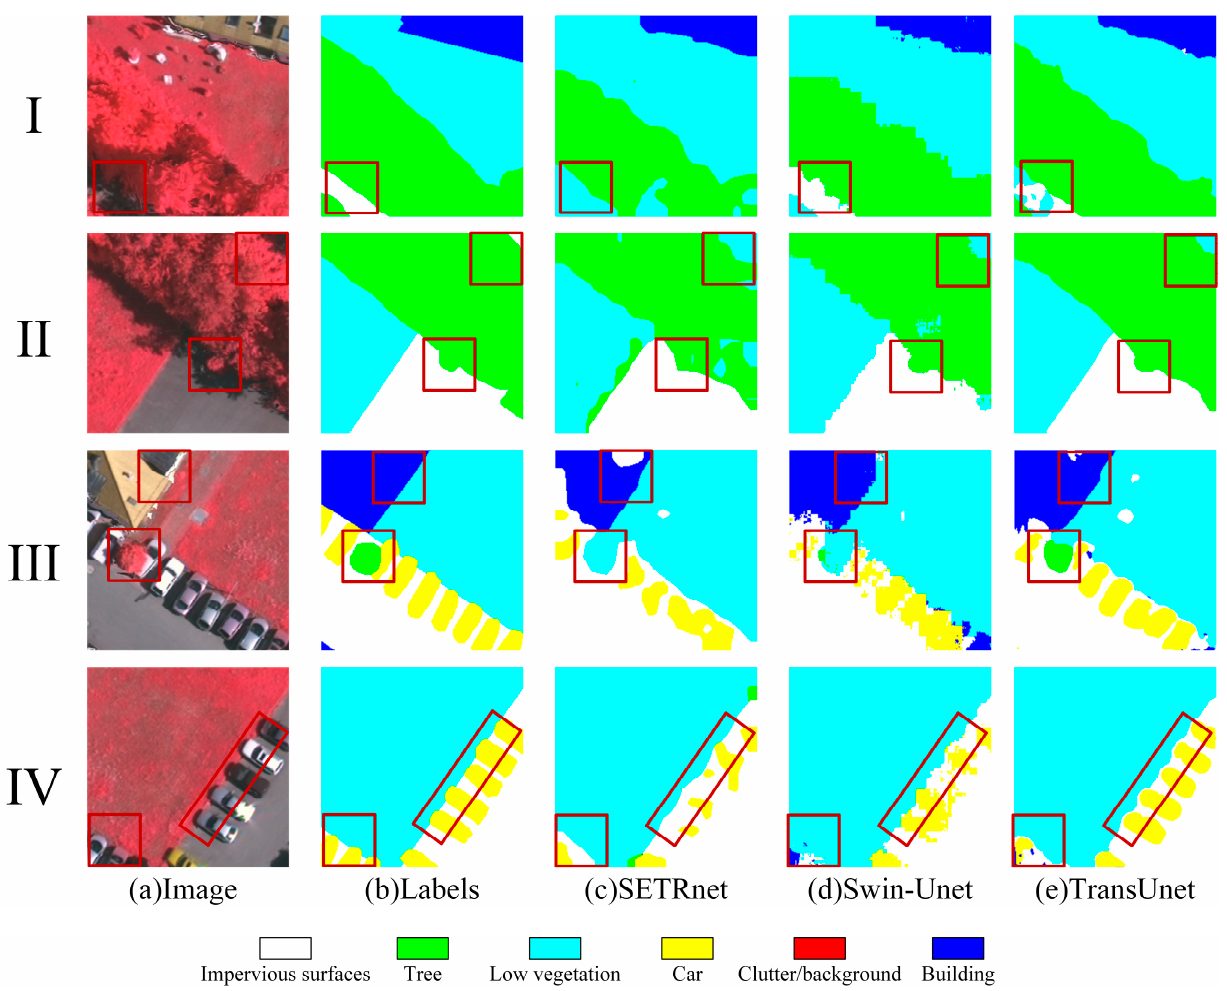
Figure 11. Comparison of transformer’s segmentation results in the Vaihingen data set. The red boxes are where the differences between the three network segmentations are large.